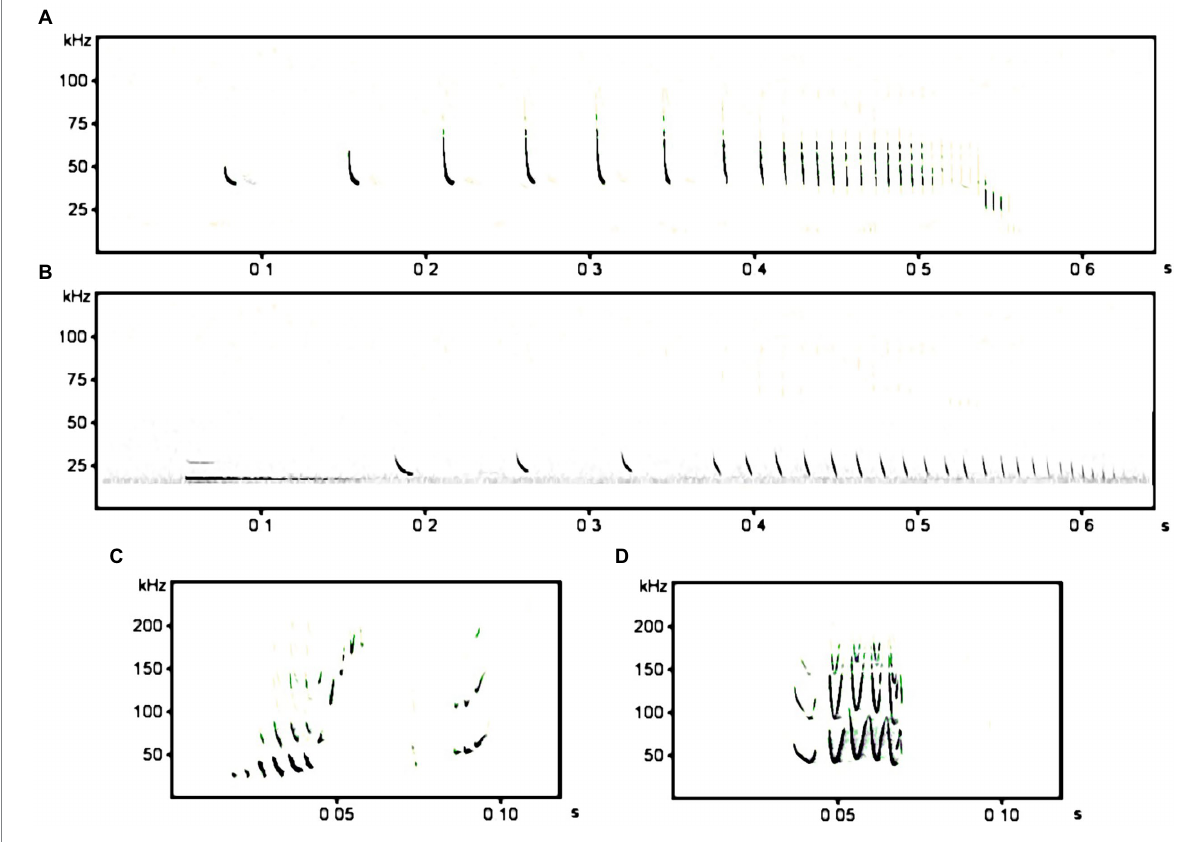
FIGURE 1 Spectrograms (frequency (kHz) in relation to time (s)) of examples for the stimulus type “feeding buzzes” of Pipistrellus nathusii (A) and Nyctalus noctula (B) . The courtship vocalization of a male P. nathusii (C) and the main motif of a male N. noctula courtship song (D)